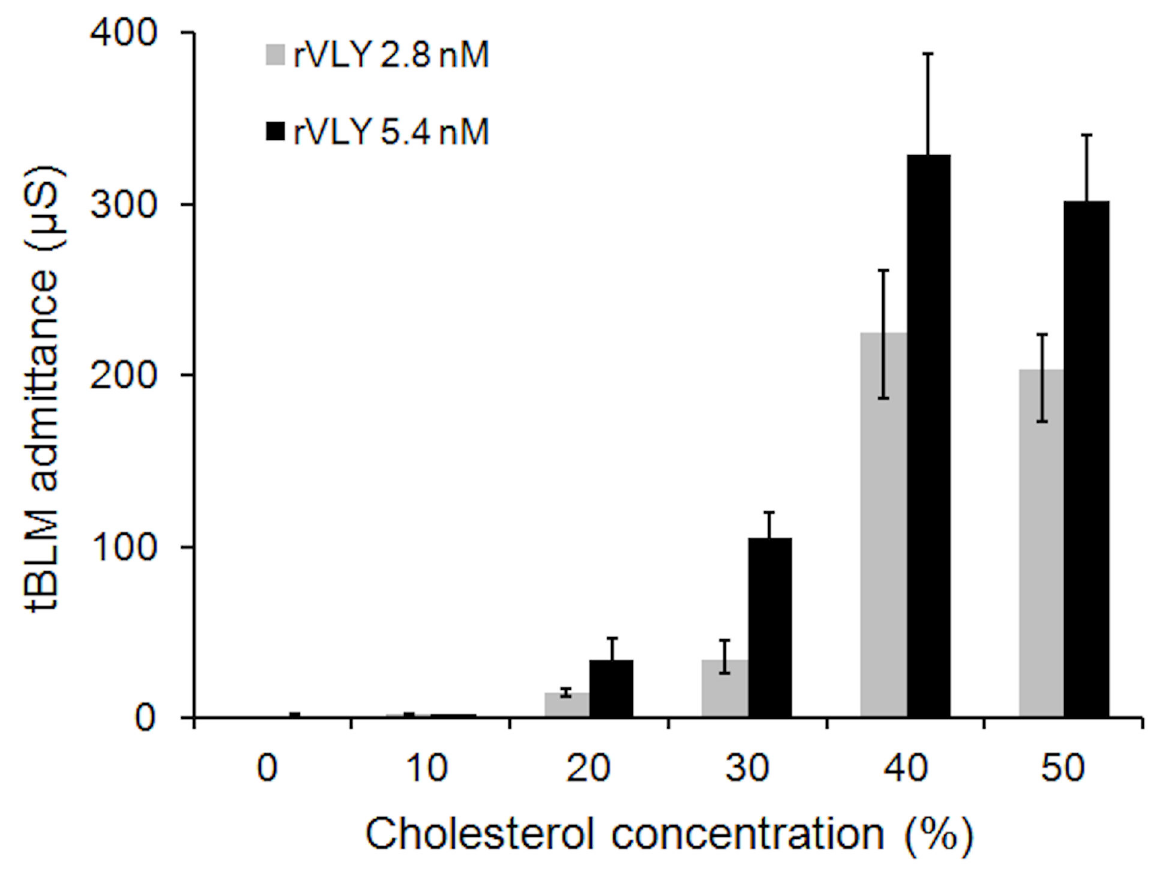
Figure 2. Cholesterol concentration-dependent tBLM admittance change triggered by rVLY. EIS recorded 30 min after the injection of rVLY. Incubation time 30 min.